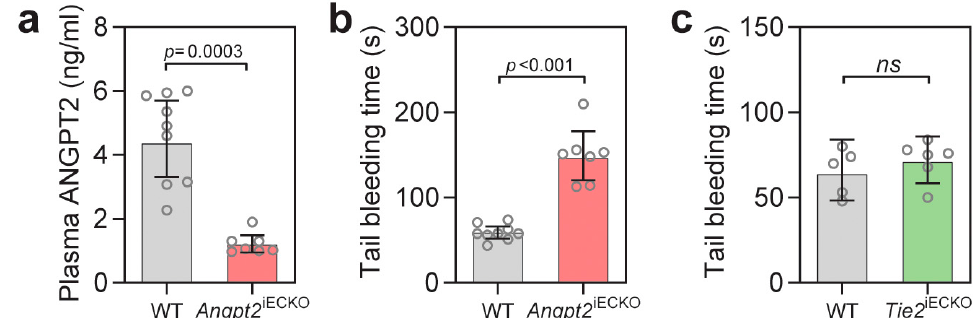
Figure 2. ( a ) Plasma concentration of ANGPT2 in Angpt2 iECKO mice and wildtype (WT) littermate controls; ( b ) Tail bleeding time in Angpt2 iECKO mice and wildtype (WT) littermate controls. ( c ) Tail bleeding time in Tie2 iECKO mice and littermate controls (WT). Data presented as mean ± 95% CI. Statistical comparison with Student’s t -test.